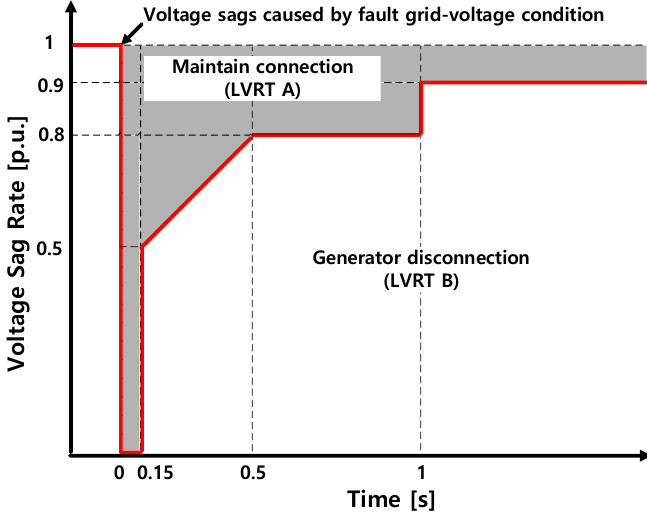
Figure 1. Low-voltage ride-through (LVRT) requirement.